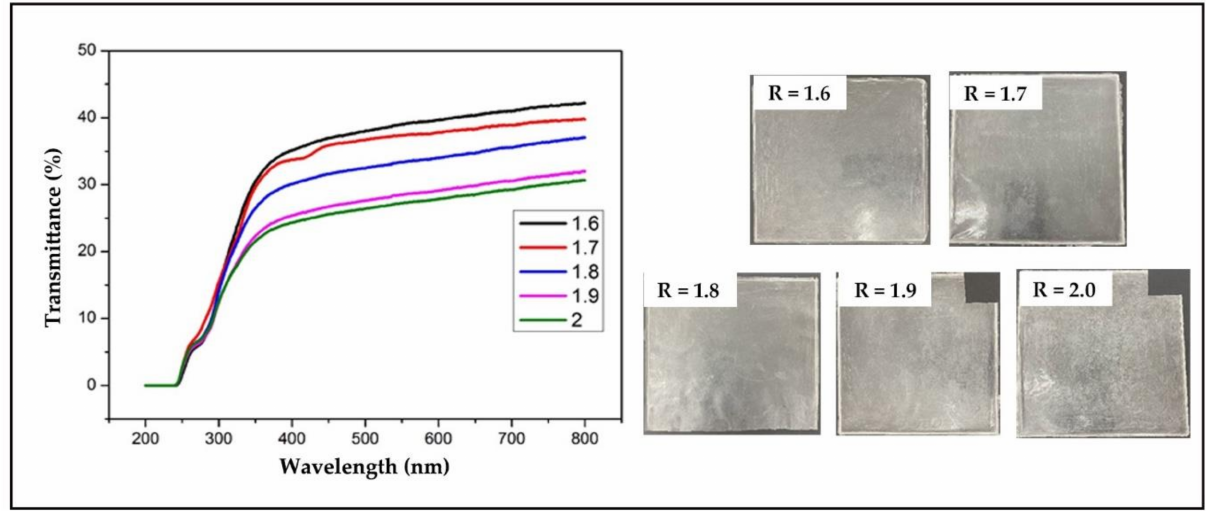
Figure 11. UV transmittance spectrum and photos of SPU films with different R